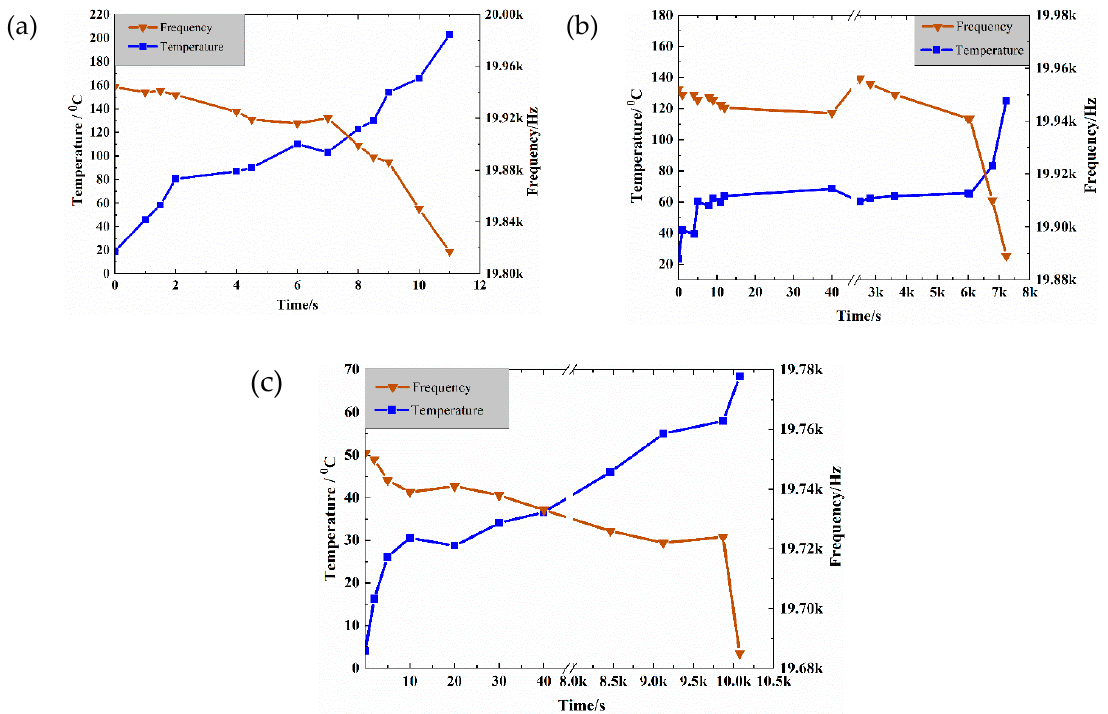
Figure 6. Evolution of the temperature (blue) and the frequency (red) when using ( a ) compressed cold air, ( b ) intermittent loading, and ( c ) liquid nitrogen cooling.